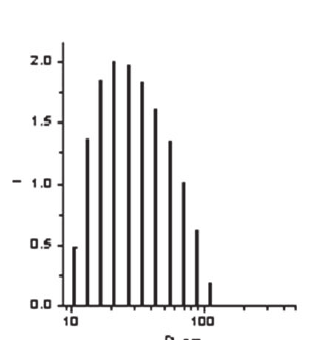
Figure 4: Average hydrodynamic diameter and particles size distribution of aqueous solution of γ Fe 2 O 3 nanoparticles.